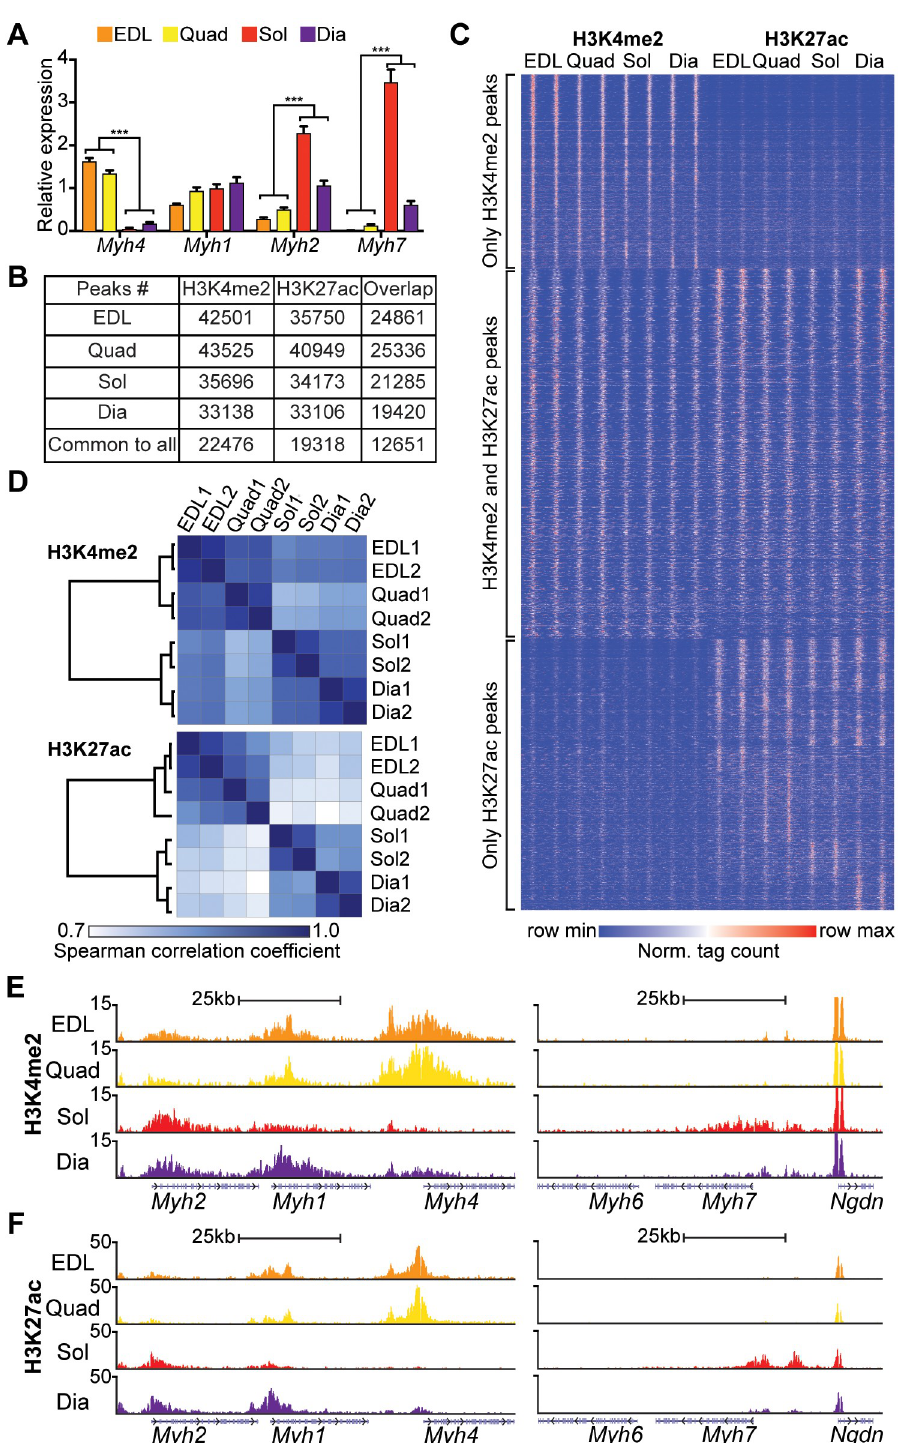
Fig 1. Skeletal muscles exhibit varied cis -regulatory repertoires. (A) qPCR expression analysis of Myh isoforms measured in different muscle groups (EDL, Quad, Dia, Sol) ( n = 5/group). Data are represented as means ± SEM. ��� p < 0.001. (B) Number of H3K4me2 and H3K27ac peaks identified by ChIP-seq. (C) Heatmap distribution of H3K4me2 and H3K27ac tags within 6 kb of all H3K4me2 and/or H3K27ac peaks identified in EDL, Quad, Sol, and Dia; n = 2/group. (D) Similarity matrix for H3K4me2 (top) and H3K27ac (bottom) profiles across muscle groups. Spearman rank correlation coefficient (r s ) is represented in color. (E,F) Representative UCSC browser tracks of